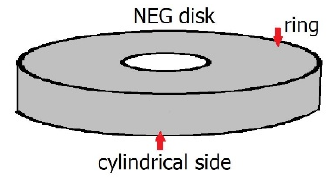
Figure 22. Getter disk replicated for the TPMC model simplifying the geometry to an upper and lower ring surface, and a cylindrical side representing the disk thickness.